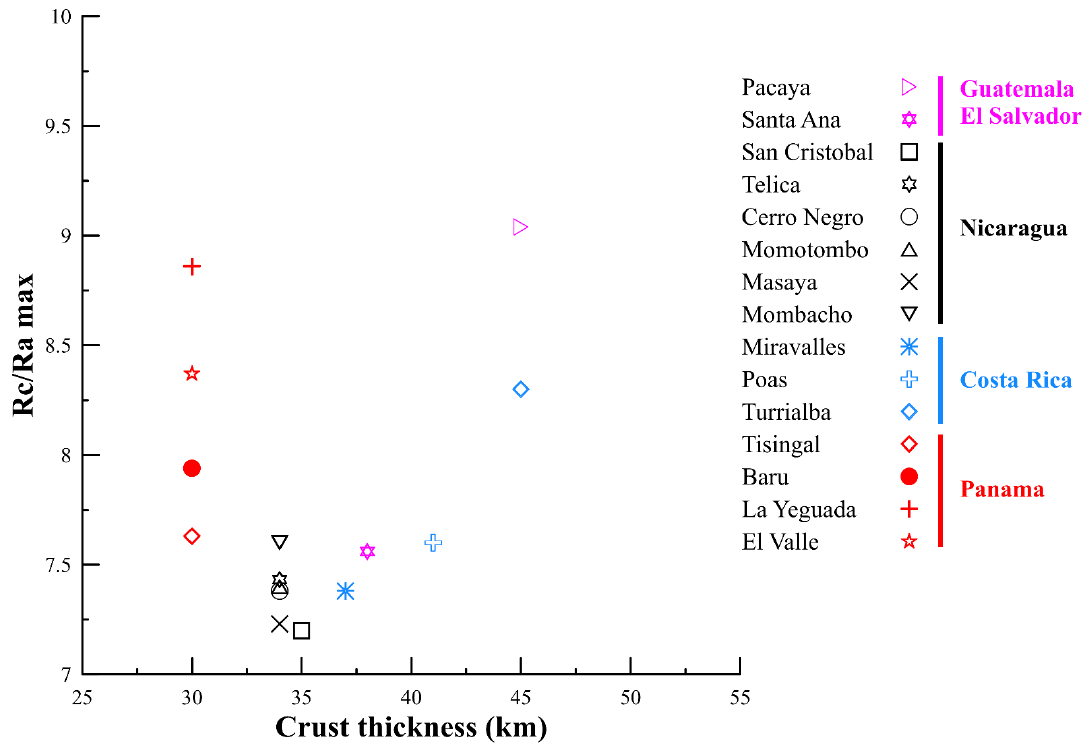
Figure 4. Crust thickness versus the maximum 3 He/ 4 He corrected for atmospheric contamination (Rc/Ra) measured in a selection of volcanoes from different segments of CAVA. Data selection is based on the criteria discussed in the text . Data source for the volcanoes, other than Telica and Baru, is reported in Figures 2 and 3 captions and in Tables S3 and S4. Crust thickness values below the selected volcanoes are from [16,17–19,106].